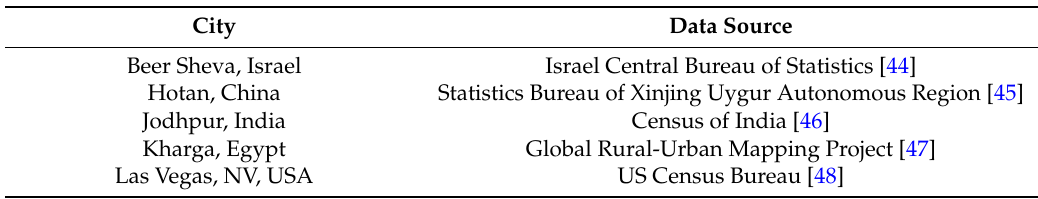
Table 1. Data source for